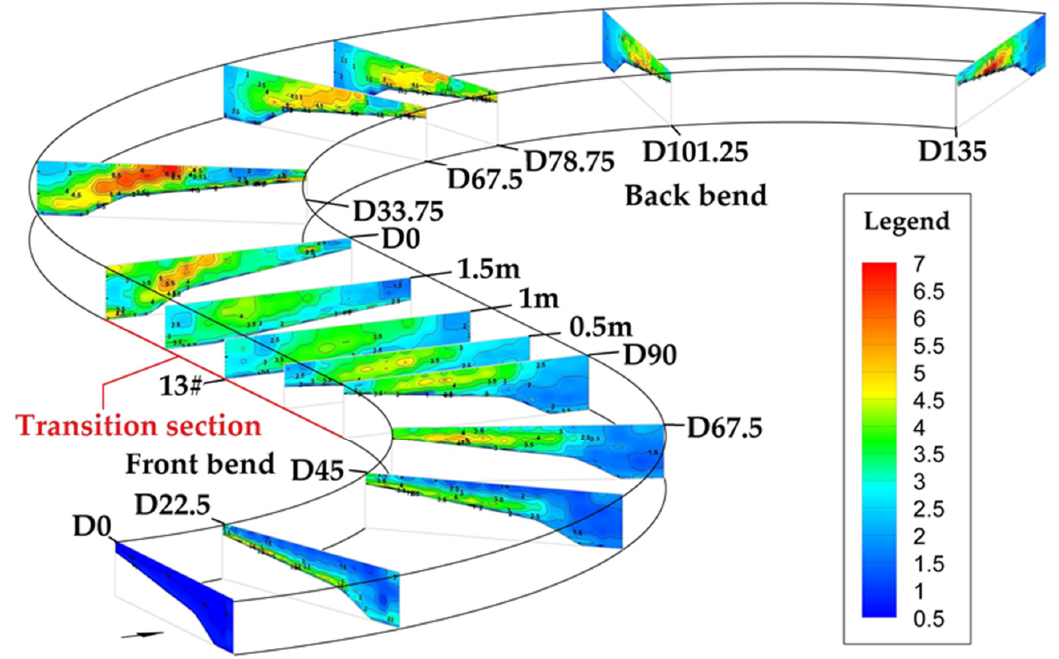
Figure 11. Distribution of Turbulent Kinetic Energy (TKE) along the continuous bend at Q3 (m 2 /s 2 ).